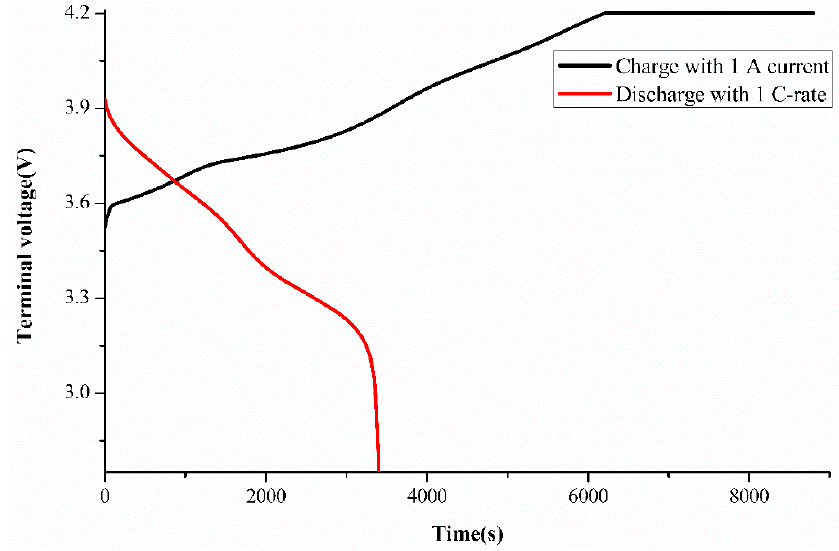
Figure 1. Variation of terminal voltage recorded during the charge–discharge period.